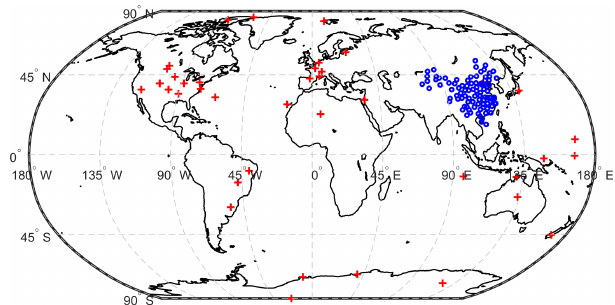
Figure 1. Distribution of radiation measurement stations used to evaluate the performance of the estimated SSR. The blue circles mark the locations of the 90 CMA radiation stations, and the red crosses mark those of the 42 BSRN stations. Note that two stations (labeled as DAR and DWN) in Australia and two stations (labeled as BIL and E13) in North America are very close to each other.